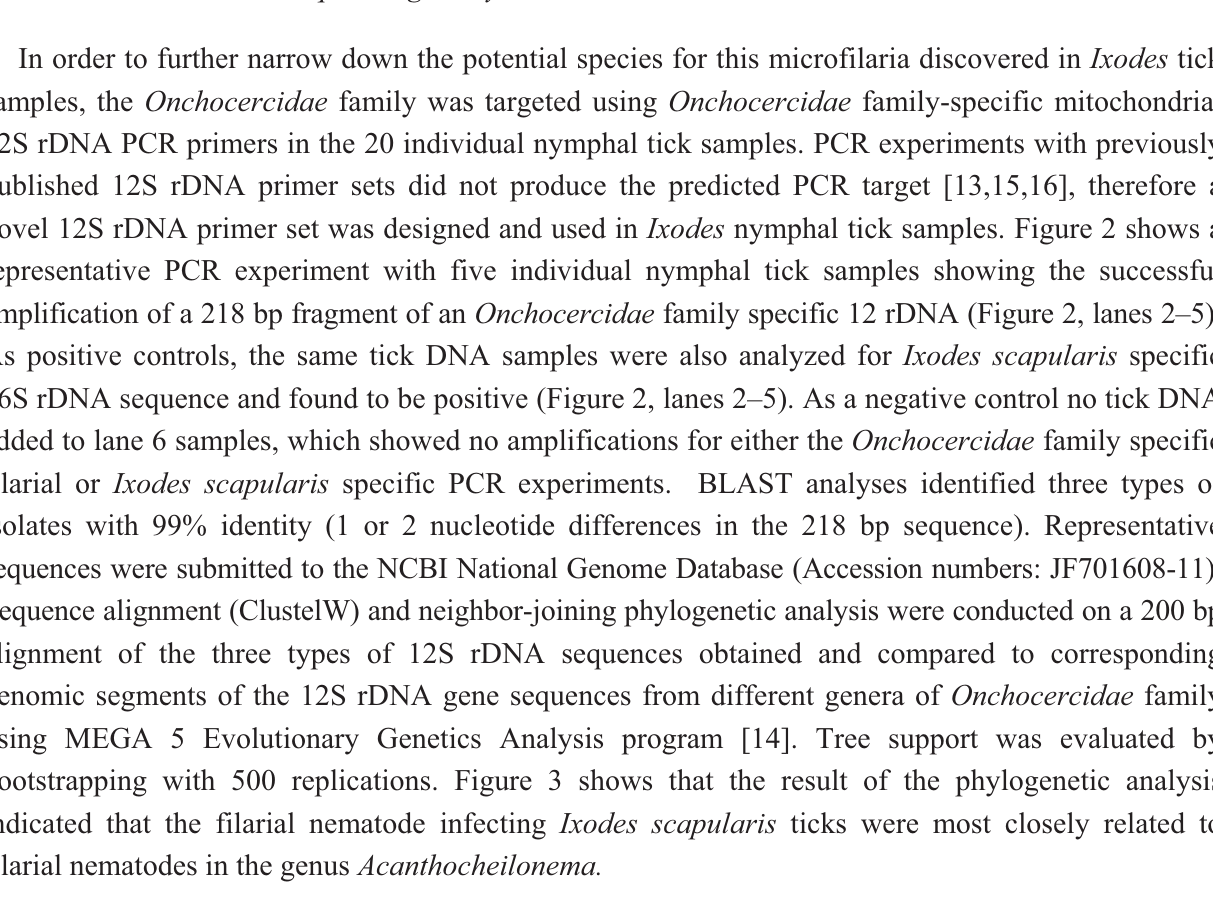
Figure 2. Polymerase chain reaction (PCR) performed using Onchocercidae family specific primers for mitochondrial 12S rDNA gene (upper panel) and for Ixodes scapularis specific 16S rDNA (lower panel). DNA isolated from five individual nymphal tick DNA samples (lanes 1–5). Lane 6 shows the negative control (no DNA) for both PCR reactions. Lane M is a 50 bp molecular weight ladder from Fisher